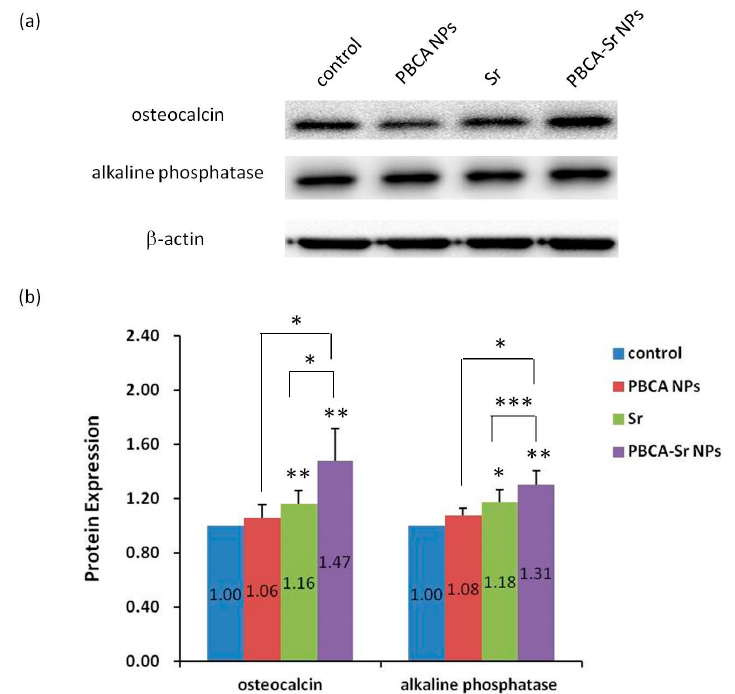
Figure 4. ( a ) Western blot analysis of osteocalcin and alkaline phosphatase at day-7 after treated with PBCA NPs (50 μ g/mL), strontium ranelate (0.1 mM) or PBCA-Sr NPs (50 μ g/mL